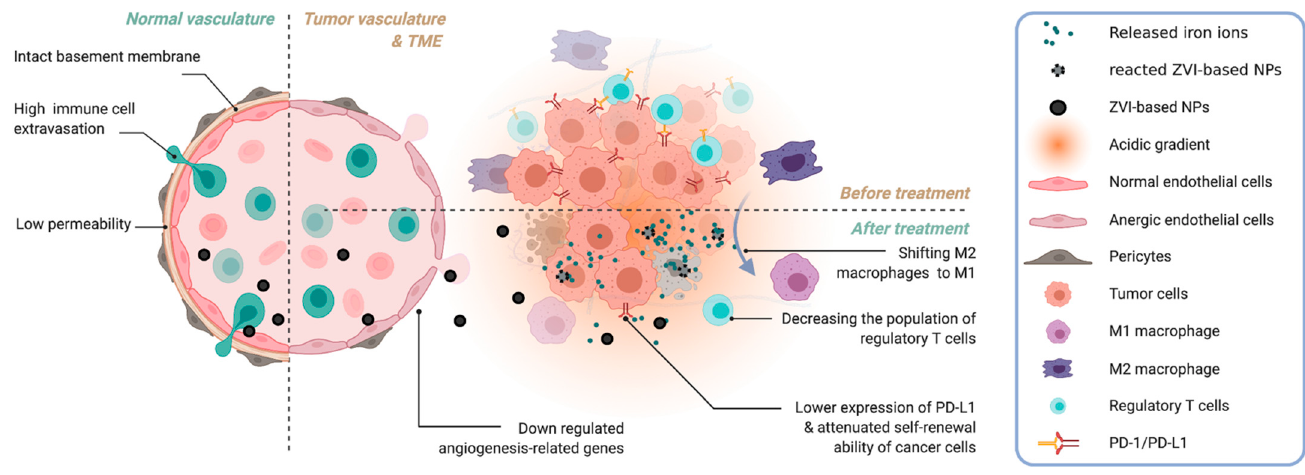
Figure 2. ZVI-NPs systemically deteriorate cancer cells through modulation of the surrounding blood vessels and immune cells that compose the TME. Adapted from “Features of Tumor Blood Vessels”, by BioRender (2021).